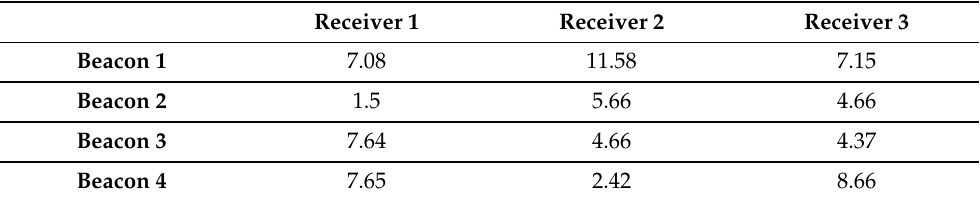
Table 4. Receiver-fingerprinting beacon distance